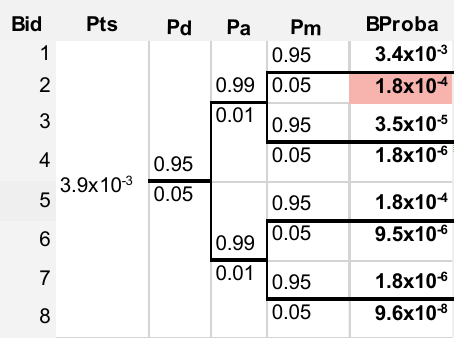
Figure 14. Event tree for the intrusion of an authorized off-nominal cooperative drone in LIMC 35 departure path when take-off is occurring.